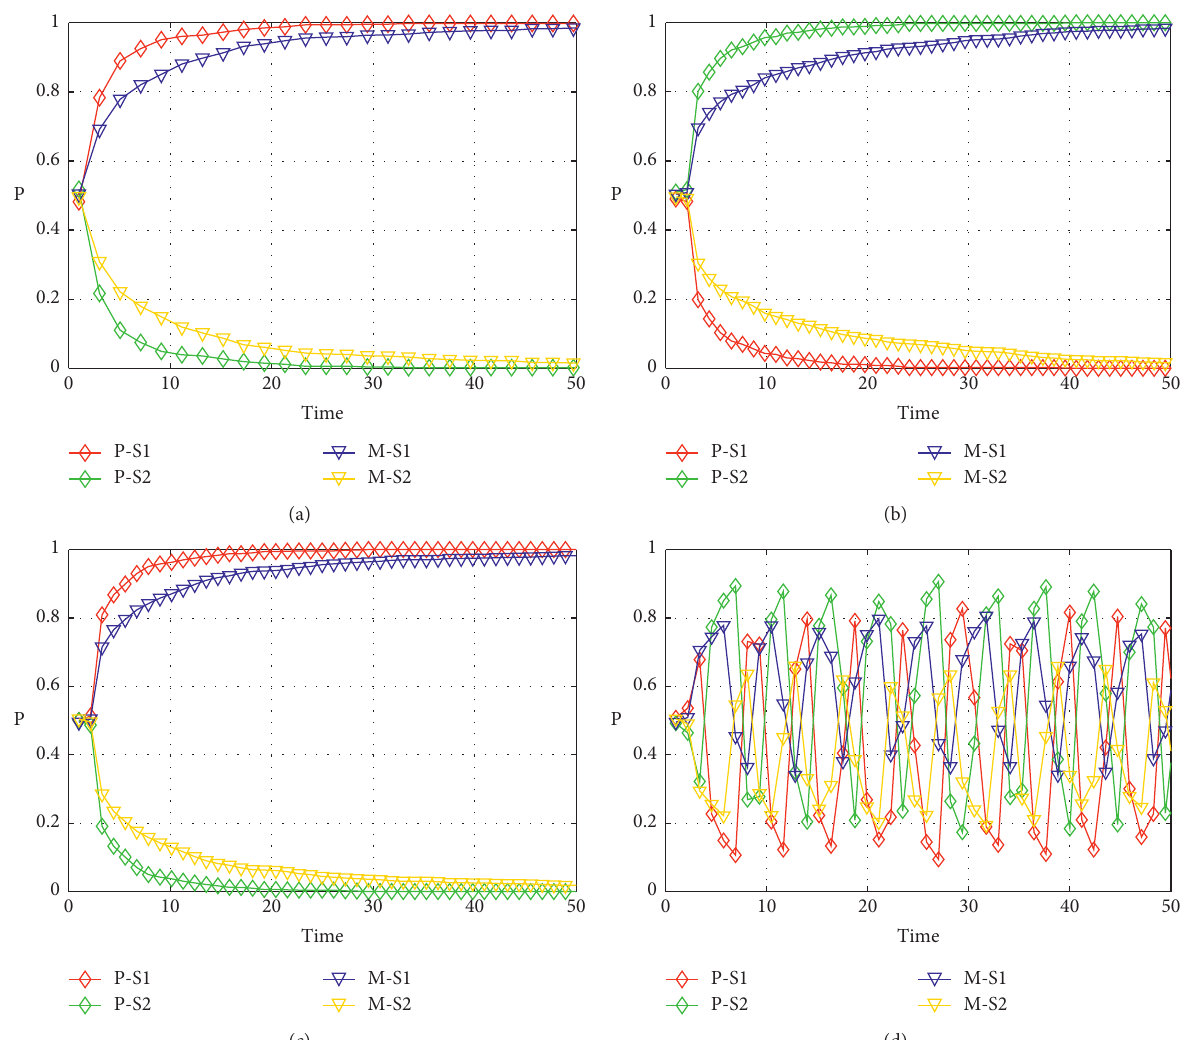
Figure 2: The simulation results. (a) Case 1. (b) Case 2. (c) Case 3. (d) Case 4.